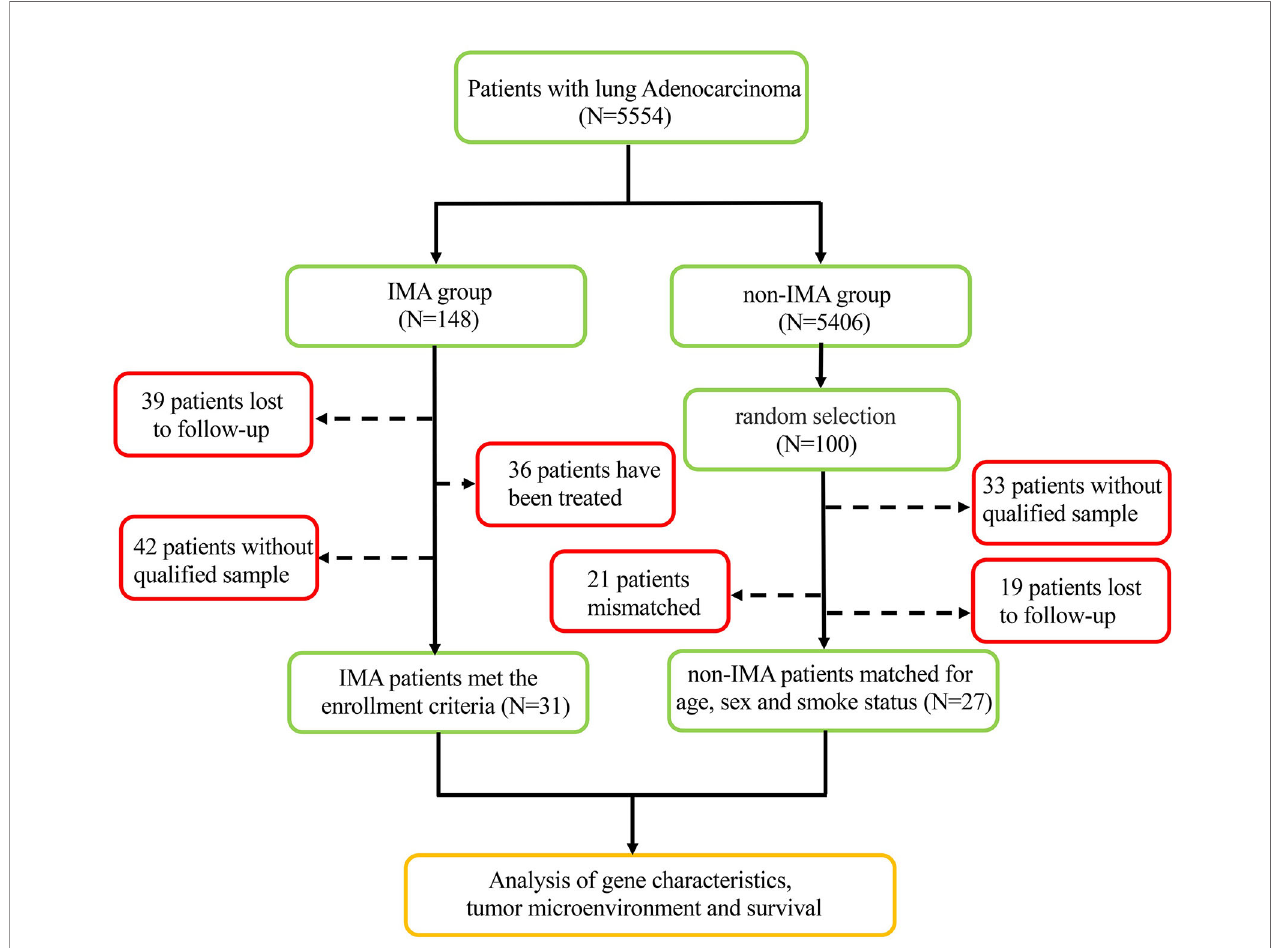
FIGURE 1 | Flow chart of the protocol followed for patients ’